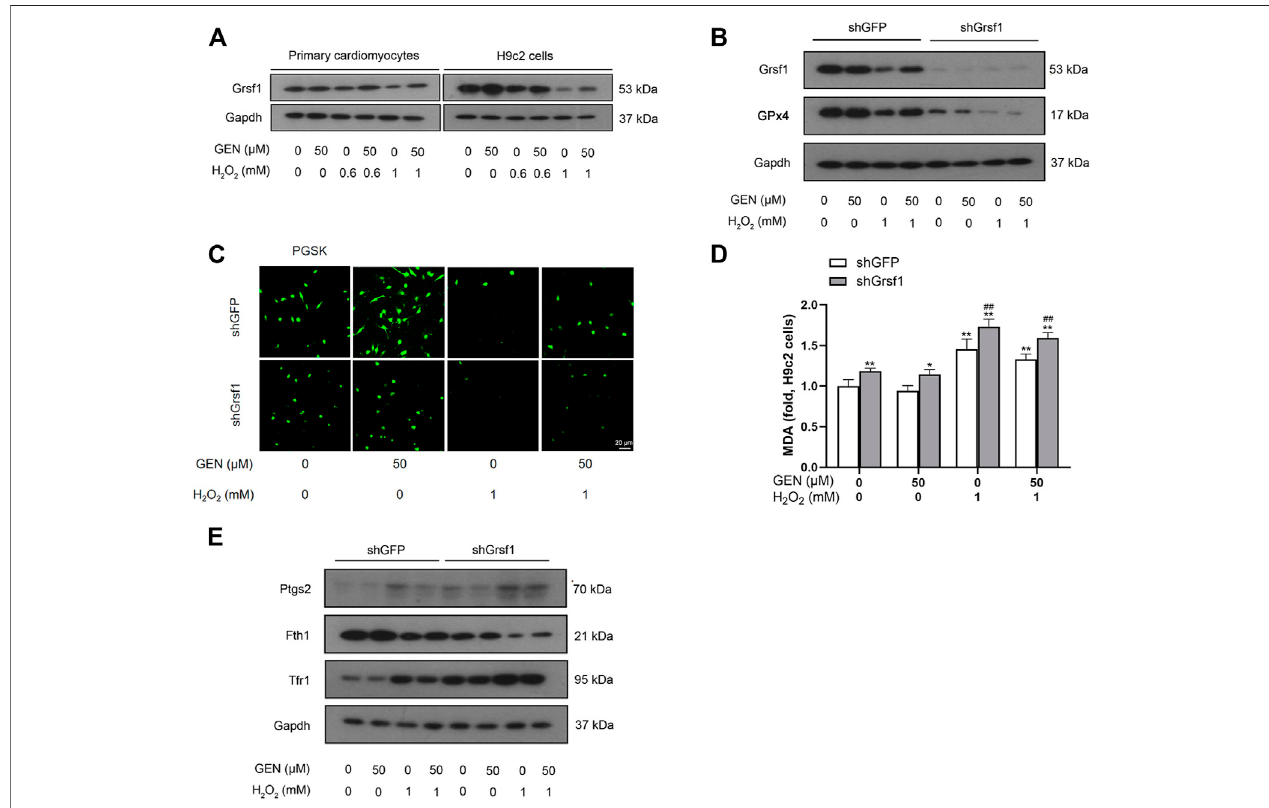
FIGURE 3 | Knockdown of Grsf1 sensitizes cardiomyocytes to H 2 O 2 -induced ferroptosis and weakens the protective effect of GEN against myocardial injury. (A) Protein expression of Grsf1 in H 2 O 2 -induced primary cardiomyocytes and H9c2 cells treated with GEN. (B) Effect of GEN on protein expressions of Grsf1 and GPx4 in H 2 O 2 -induced H9c2 cells after knockdown of Grsf1. (C,D) Iron level and MDA content in H 2 O 2 -induced H9c2 cells after knockdown of Grsf1 and treatment of GEN. (E) Effect of GEN on the expressions of the ferroptosis-related proteins Ptgs2, Fth1, and Tfr1 in H 2 O 2 -induced H9c2 cells after knockdown of Grsf1. Data were expressed as mean ± SD ( n = 5). * p < 0.05, ** p < 0.01 vs. shGFP control group; # p < 0.05, ## p < 0.01, shGrsf1 group vs. shGFP group. Scale bar = 20